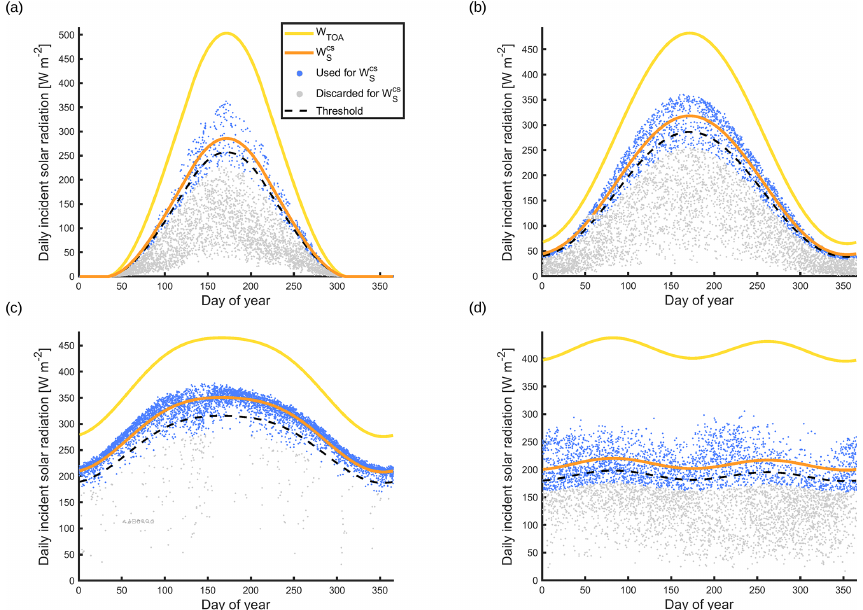
Figure 6. Examples of cloud masking based on incoming shortwave radiation at (a) 73.25 ◦ N/11.75 ◦ E, (b) 53.25 ◦ N/11.75 ◦ E, (c) 23.25 ◦ N/11.75 ◦ E, and (d) 3.25 ◦ N/11.75 ◦ E. The yellow line shows daily incoming solar radiation at the top of atmosphere accord- ing to Berger (1978), the orange line shows fitted incoming shortwave radiation at the surface under clear-sky conditions, the blue dots show daily incoming solar radiation values in GSWP3 included to make this fit, the gray points show daily incoming solar radiation values in GSWP3 removed because they are below 80% of the last fit of W cs , and the dashed black line shows the threshold of 90% of W cs above S S which days are considered to have clear-sky conditions.